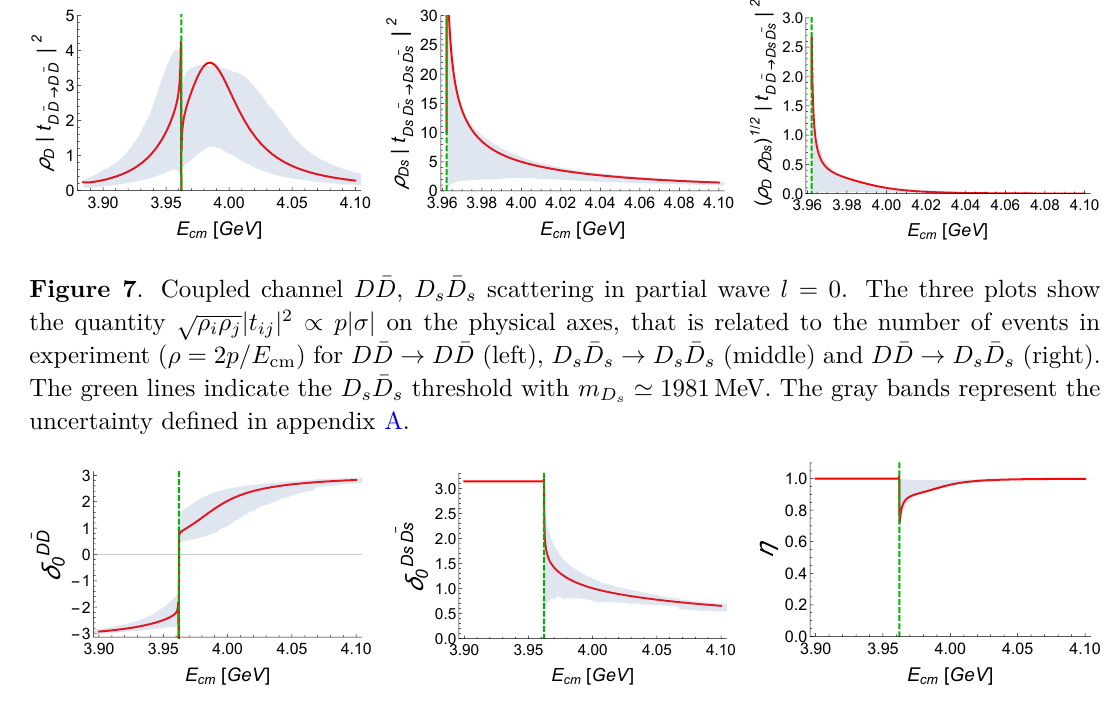
Figure 8 . Coupled channel D ¯ D , D s ¯ D s scattering in partial wave l = 0 : two phase shifts δ DD δ D s ¯ D s and inelasticity η that parametrize the 2 × 2 scattering matrix S (2.3) are shown as a 0 function of E cm . The green lines indicates the D s ¯ D s threshold with m D bands represent the